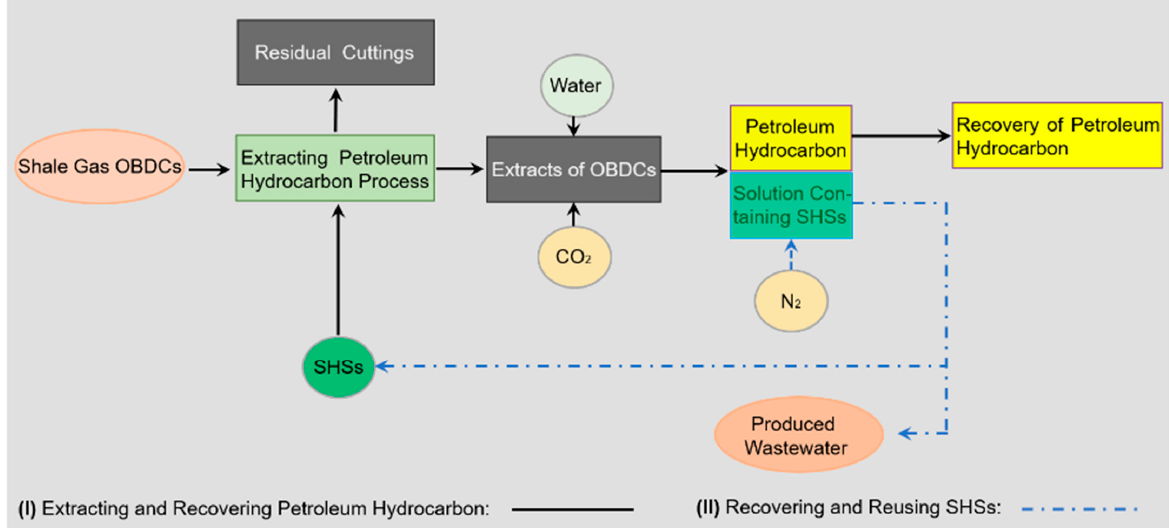
Figure 1. The treatment process of shale gas OBDCs with CO 2 SHSs.